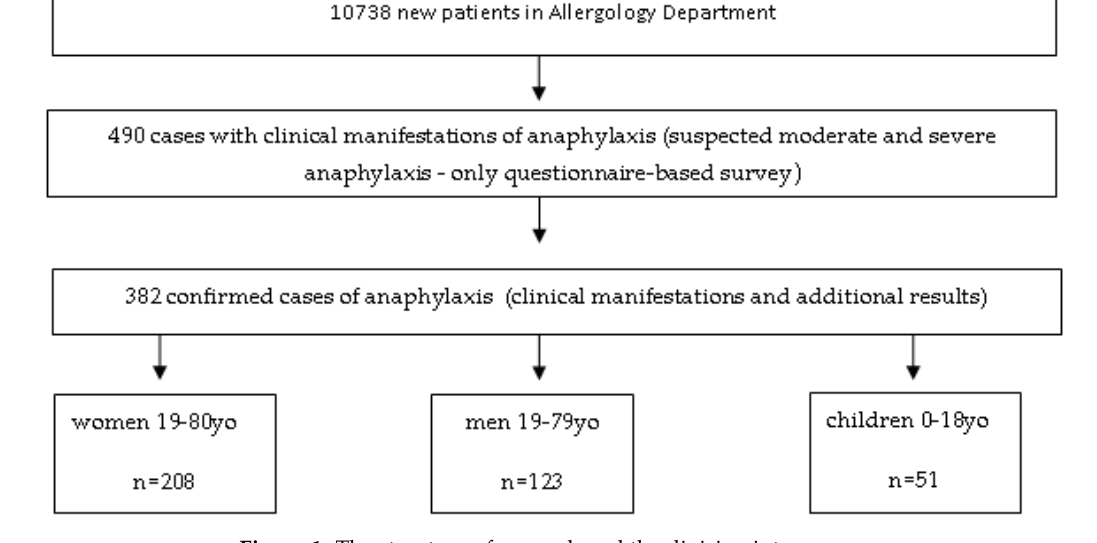
Figure 3. Organ systems involved (%) in anaphylaxis with groups divided into women, men, and children. 3.2.2. Affected Organ Systems The most common number of organ systems involved in whole group was two or three (Figure 4), compared to one or four organ systems ( p = 0.000). Figure 4. % of case anaphylaxis with 1, 2, 3 or 4 affected organ systems (in the whole group). Organ systems involved (%) in anaphylaxis with a group division: women, men, and children. Clinical manifestations involving one organ system was less common in children than women ( p = 0.044) and men ( p = 0.033). Four organ systems were involved more frequently in children than in women ( p = 0.032). This relationship is shown in Figure 5.